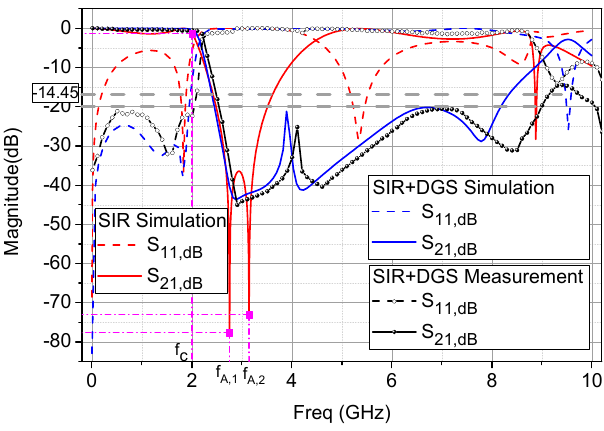
Figure 9. The simulation and measured results of S-parameters